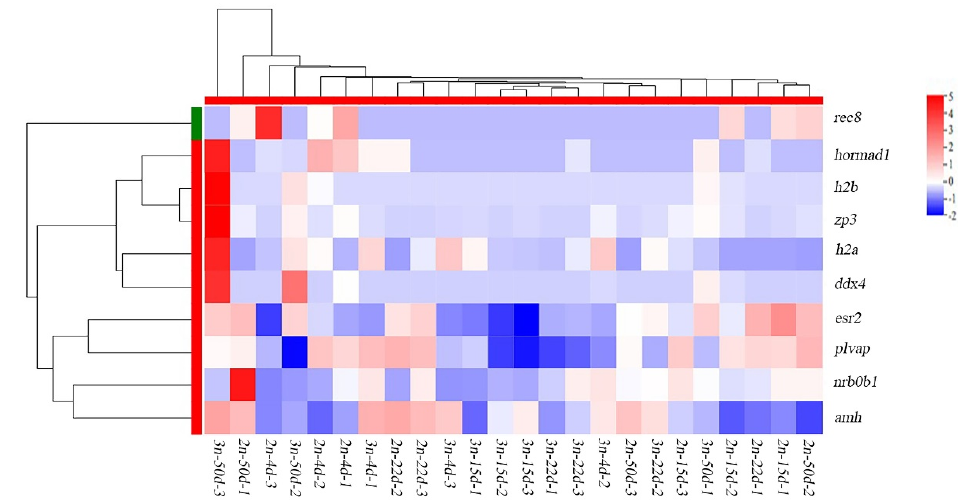
Figure 9. Cluster analysis heat map of fertility-related DEGs in the gonads of loaches. Each row in the graph represents a gene and different colors represent different gene expression levels; the range red to blue indicates high to low expression levels, respectively (2n: diploid; 3n: hybrid triploid; d: days post-hatching).